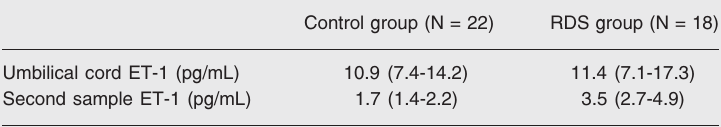
Table 2. Umbilical cord and second sample endothelin-1 (ET-1)